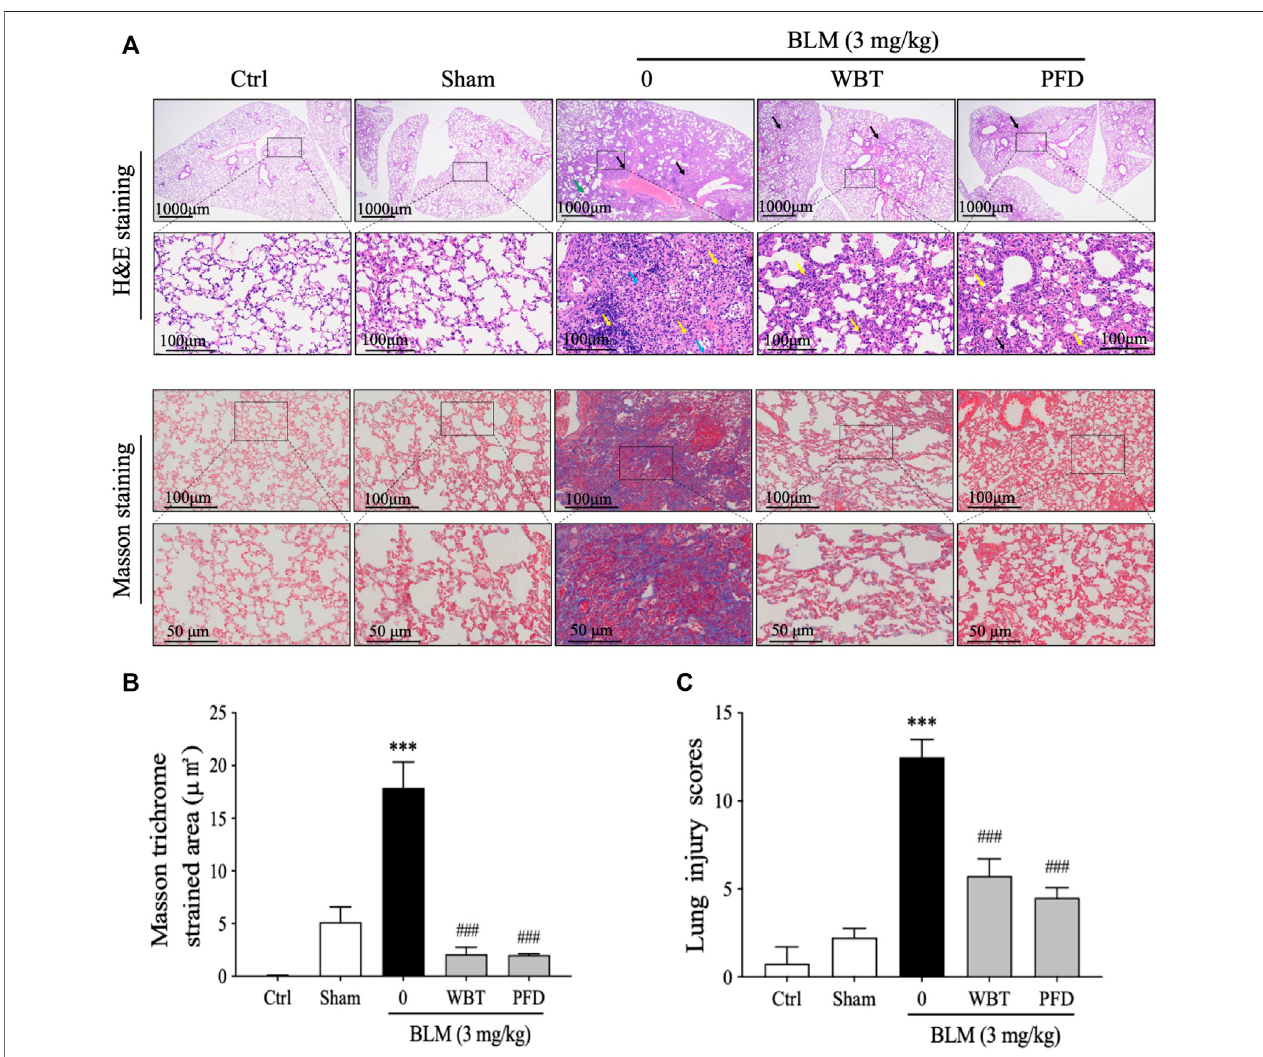
FIGURE 5 | WBT formula attenuated BLM-induced lung fi brosis after 14-day treatment. (A) H&E and Masson ’ s trichrome stainings for the lung tissues from Ctrl, Sham, BLM, BLM + WBT (12 g/kg), and BLM + PFD (200 mg/kg) groups were presented (n (cid:1) 5). The images in the lower panels (scale bar (cid:1) 50 μ m) of each staining weremagni fi edfrom the insetofthe photomicrographsinthe upper panels (scale bar (cid:1) 200 μ m). (B) QuantitativeanalysisofMasson ’ strichrome stainingin thesections of mouse lungs (n (cid:1) 5). (C) The pathological score oflung injury wasanalyzed in different groups (n (cid:1) 5). *** p < 0.001, compared tothe sham group; ### p < 0.001, compared to the BLM group. BLM, bleomycin; Ctrl, control; WBT, Wenfei Buqi Tongluo formula; PFD, pirfenidone.